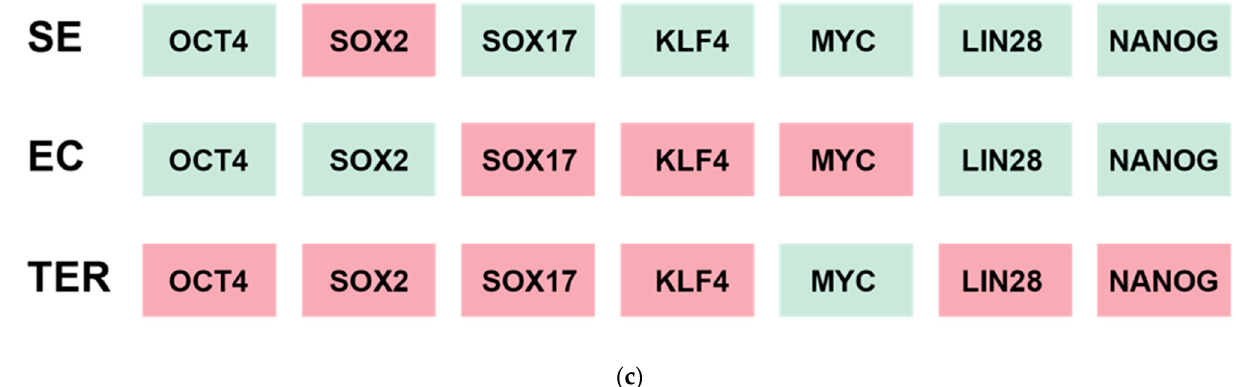
Figure 2. Development of normal and malignant testicular germ cells. ( a ) Shows the development of normal testicular germ cells from fetal life to spermatozoa in adulthood, and the development of malignant testicular germ cells from tetraploid malignant germ cells to the testicular germ cell tumors type II subtypes. Seminomas are diagnosed at a higher age than non-seminomatous testicular germ cell tumors as reflection of a lower proliferation rate in seminoma. ( b ). Chromosome 12. The short arm of chromosome 12 (12p) has two candidate regions that are especially important for the tumorigenesis of testicular germ cell tumors type II, shown in red. The candidate regions have gene loci for three driver genes: CCND2, NANOG and LDHB . The candidate regions are shown in red. The figure also shows other genes that literature and OMIM relate to TGCT. ( c ). IPSC gene panel in TGCT subtypes. The combined OSKM/OSLN panels for seminoma, embryonal carcinoma, and teratoma have dramatic differences with up- and down-regulations of the genes. Down-regulated genes are indicated with red and up-regulated genes are indicated with green.